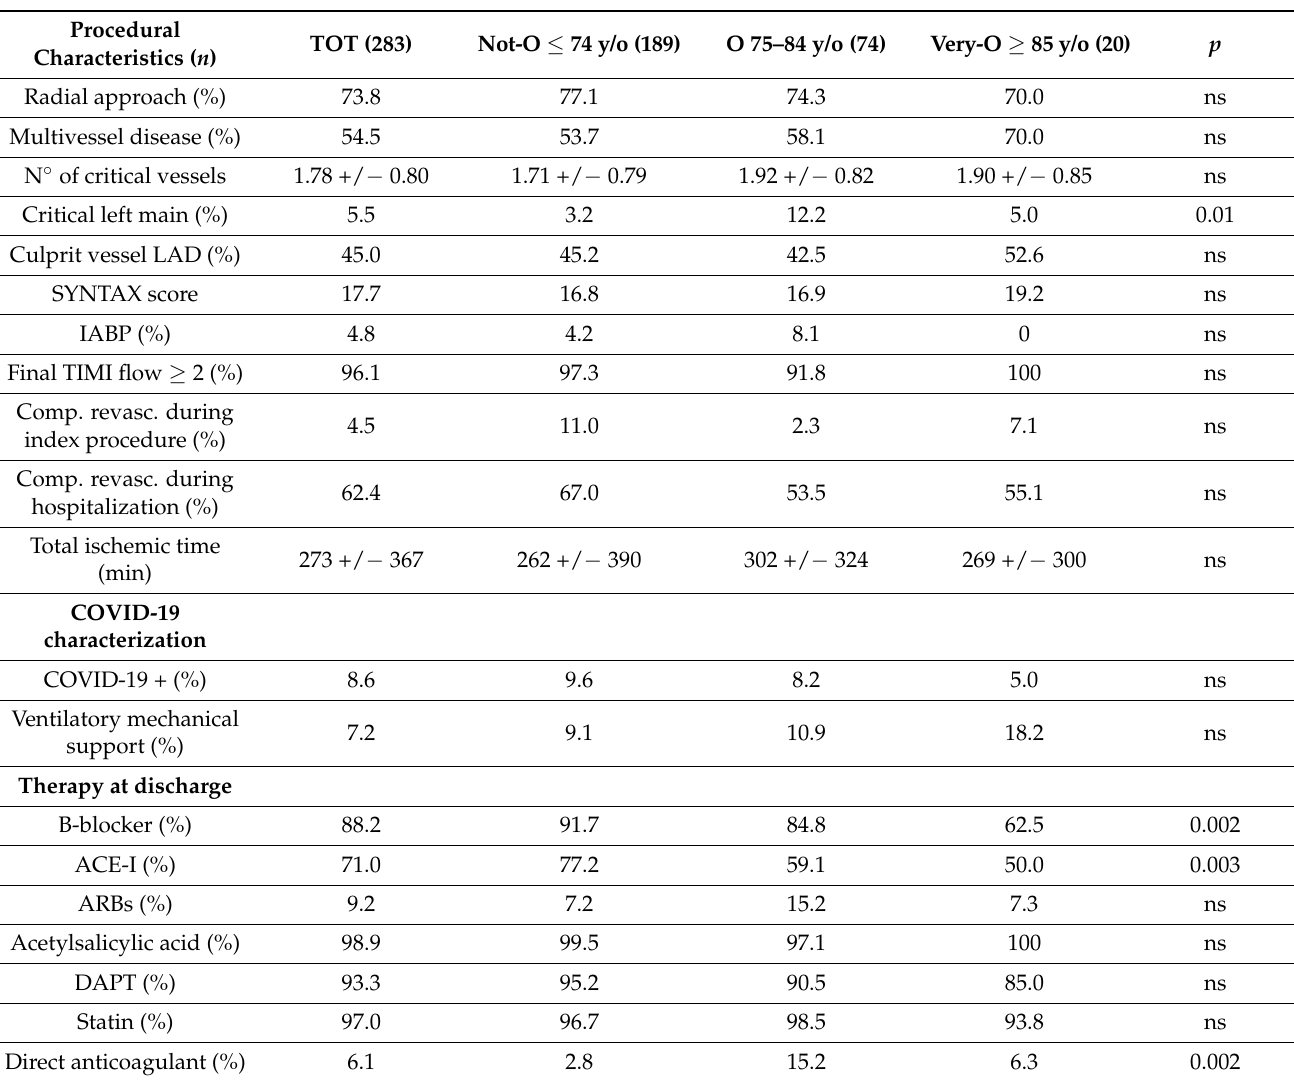
Table 2. Procedural, COVID-19, and therapeutical characteristics and